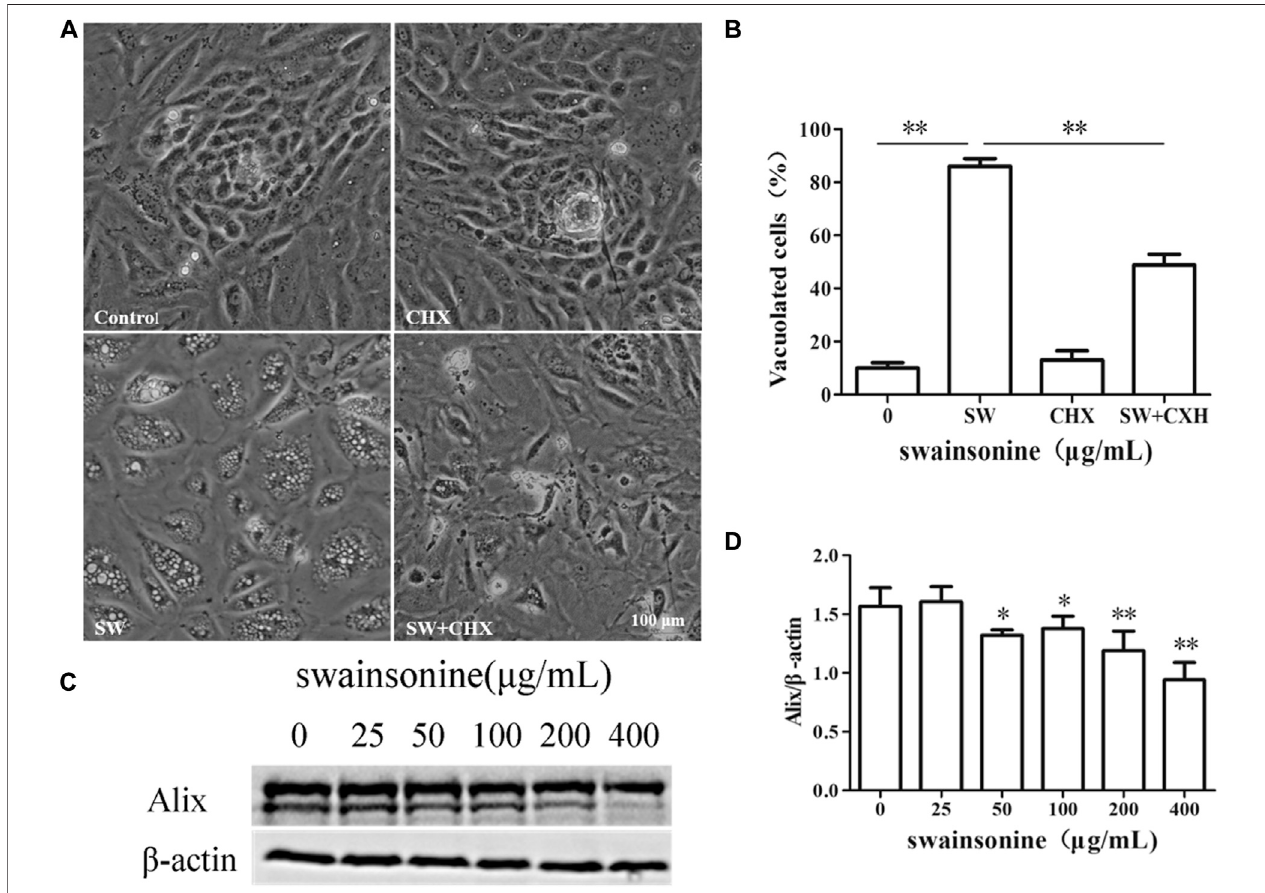
FIGURE5| SWinducedparaptosisinRTECs (A,B) RTECswerepretreated withCHXfor4 handfurthertreatedwith400 μ g/mlSWfor24 h.Invertedmicroscopic images of RTECs treated with SW (400 μ g/ml) in the presence of CHX. Morphometric analysis of vacuoles was performed with three different areas and the percentage of SW-induced vacuolated cells was calculated (C,D) Alix expression level was evaluated by Western blot analysis in RTECs treated with SW at the indicated concentrations for 24 h. Three independent experiments were performed. Statistically signi fi cance was indicated: * p < 0.05, ** p < 0.01 compared with control.